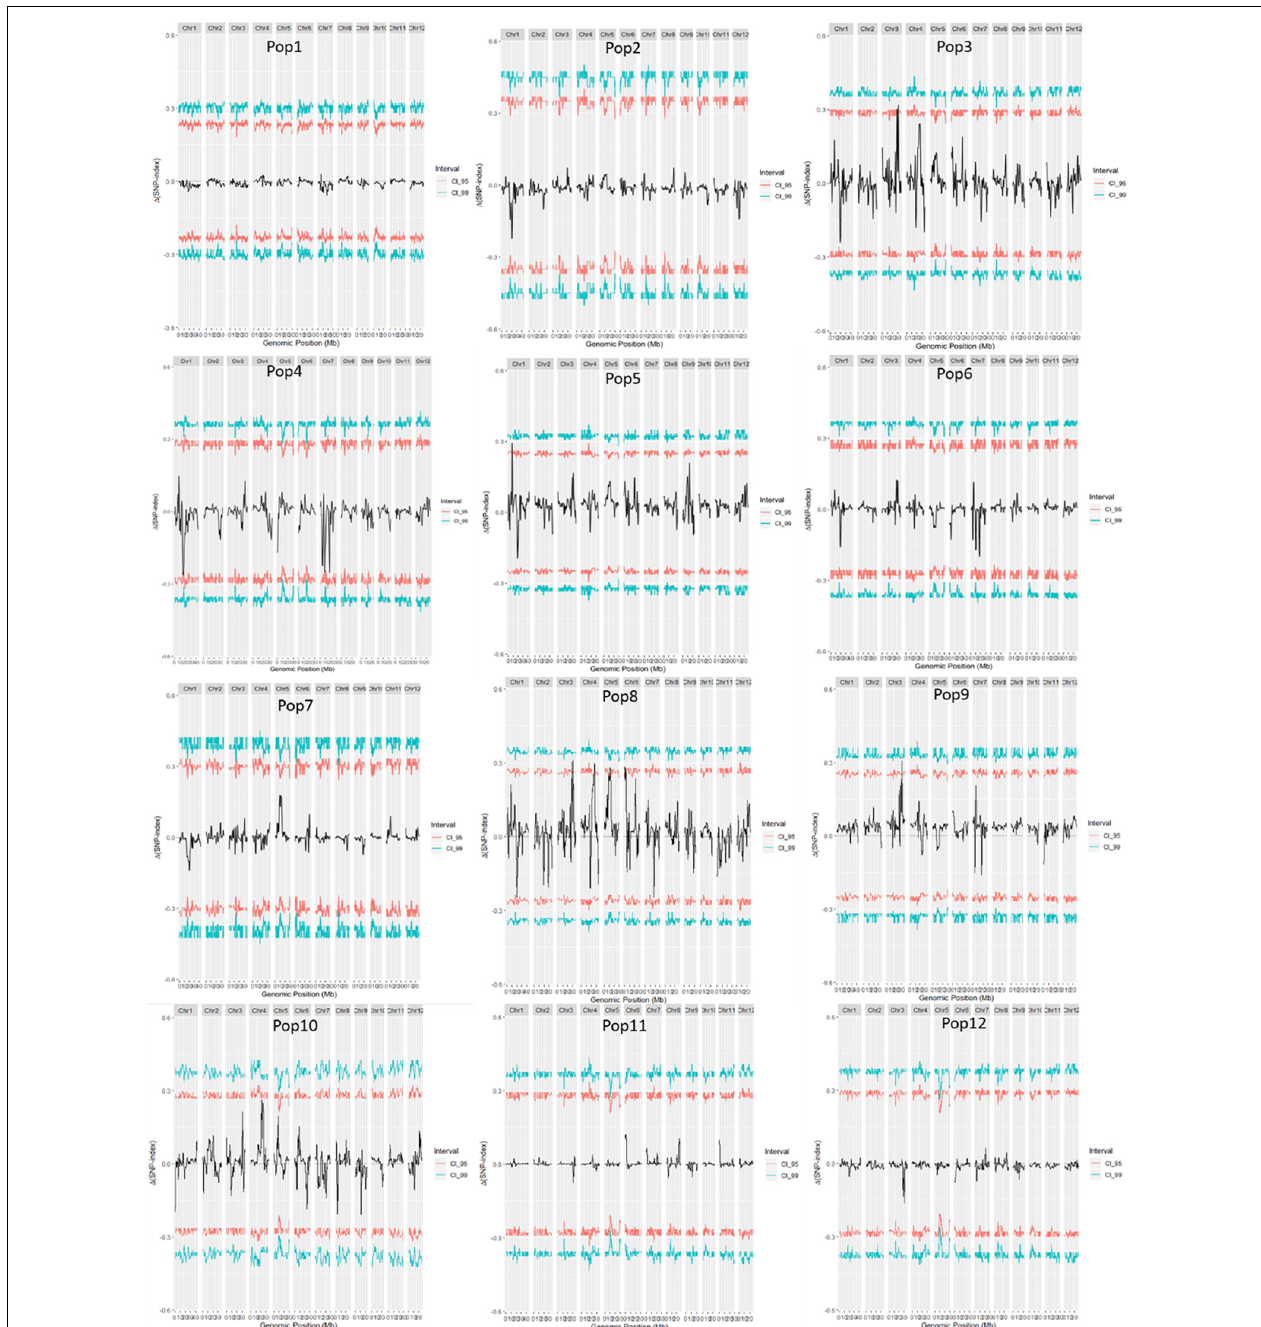
FIGURE 2 | (cid:49) (SNP-index) of 12 F 2 populations. The female parents of the 12 F 2 populations were: 79 (Pop1), Bamla Suffaid 32 (Pop2), M 136–20 (Pop3), Cash (Pop4), Balam 2 (Pop5), Kalasu (Pop6), Black 28–573 (Pop7), Bhahuri Kalasu (Pop8), Changai Kalasu (Pop9), Basmati 385 Kalasu (Pop10), IR 64 Kalasu (Pop11), and BR 11 Kalasu